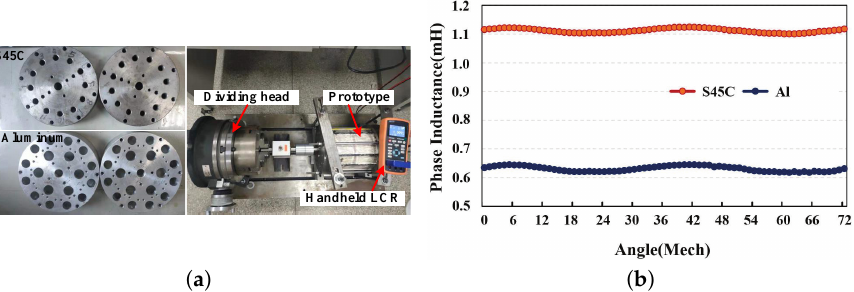
Figure 8. Different end caps and measured phase inductance. ( a ) End caps. ( b ) Measured phase in- ductance.